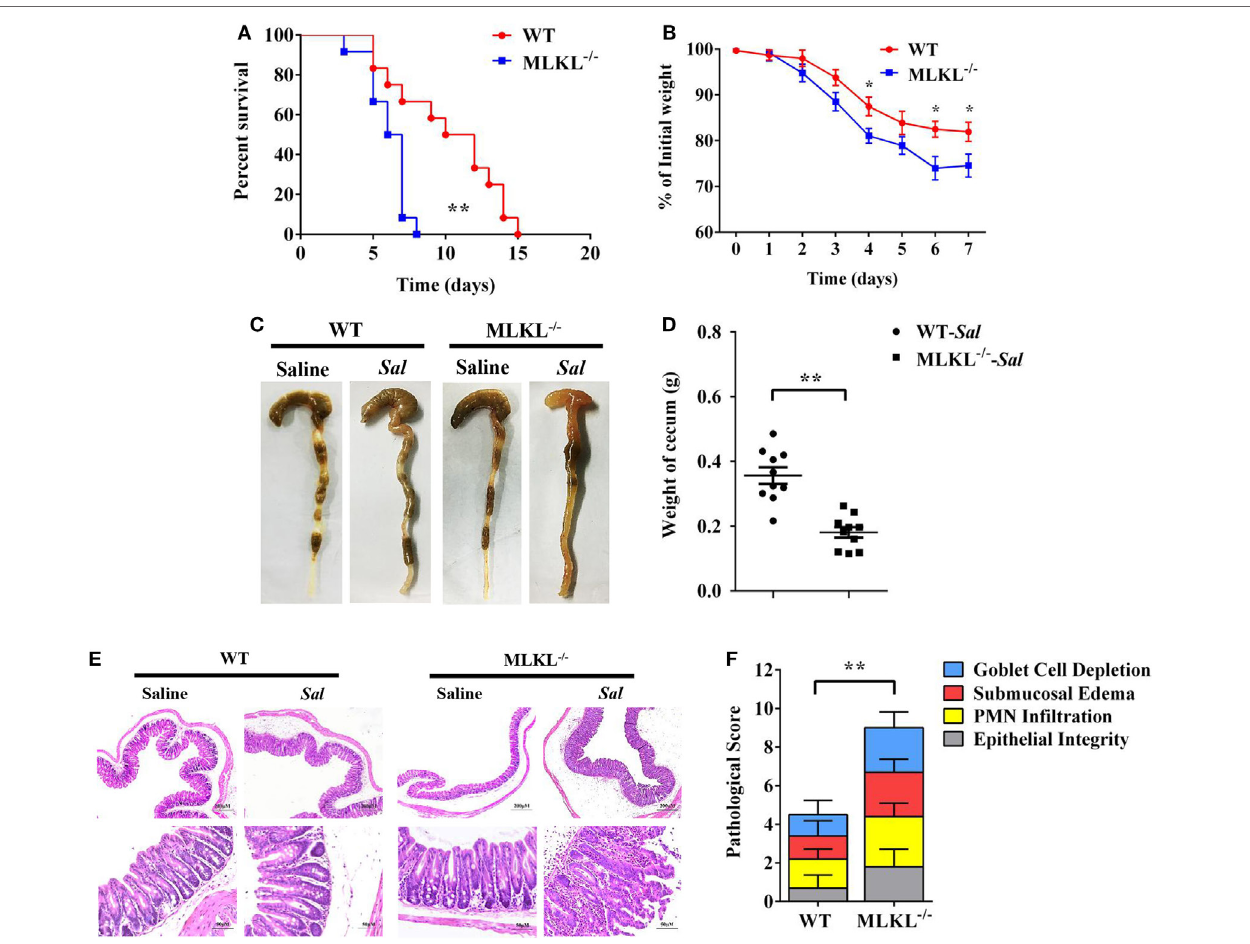
FigUre 1 | MLKL is sufficient to protect against intestinal salmonella infection. Streptomycin-pretreated WT and MLKL − / − mice were orally infected with Salmonella. (a) Survival (1 × 10 8 CFU, n = 12 each group). (B) Body weight loss (5 × 10 7 CFU, n = 12 each group). (c,D) Representative gross appearance and weight of cecum (5 × 10 7 CFU, n = 10 each group, at 48 h p.i.). (e,F) Representative H&E staining of cecum tissue and pathological score (5 × 10 7 CFU, n = 10 each group, at 48 h p.i.). All data are shown as mean ± SEM. Student’s t -test was performed. Log-rank test was used for statistical analysis of animal mortality. Statistical significance is indicated by * p < 0.05, ** p <